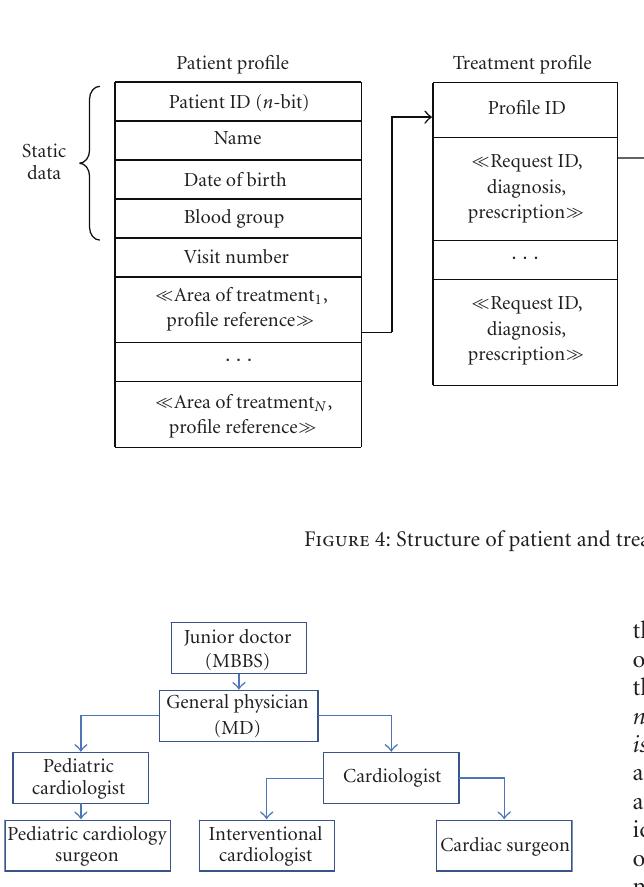
Figure 5: Hierarchy of specialists for heart